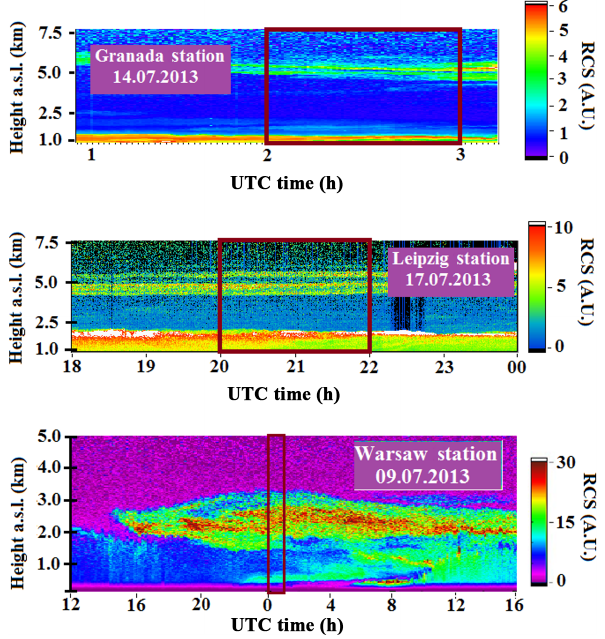
Figure 3. Time evolution of lidar raw corrected signal (in arbitrary units) at 1064nm showing the detection of the smoke plumes at Granada, Leipzig and Warsaw stations, with analyzed intervals in- side red